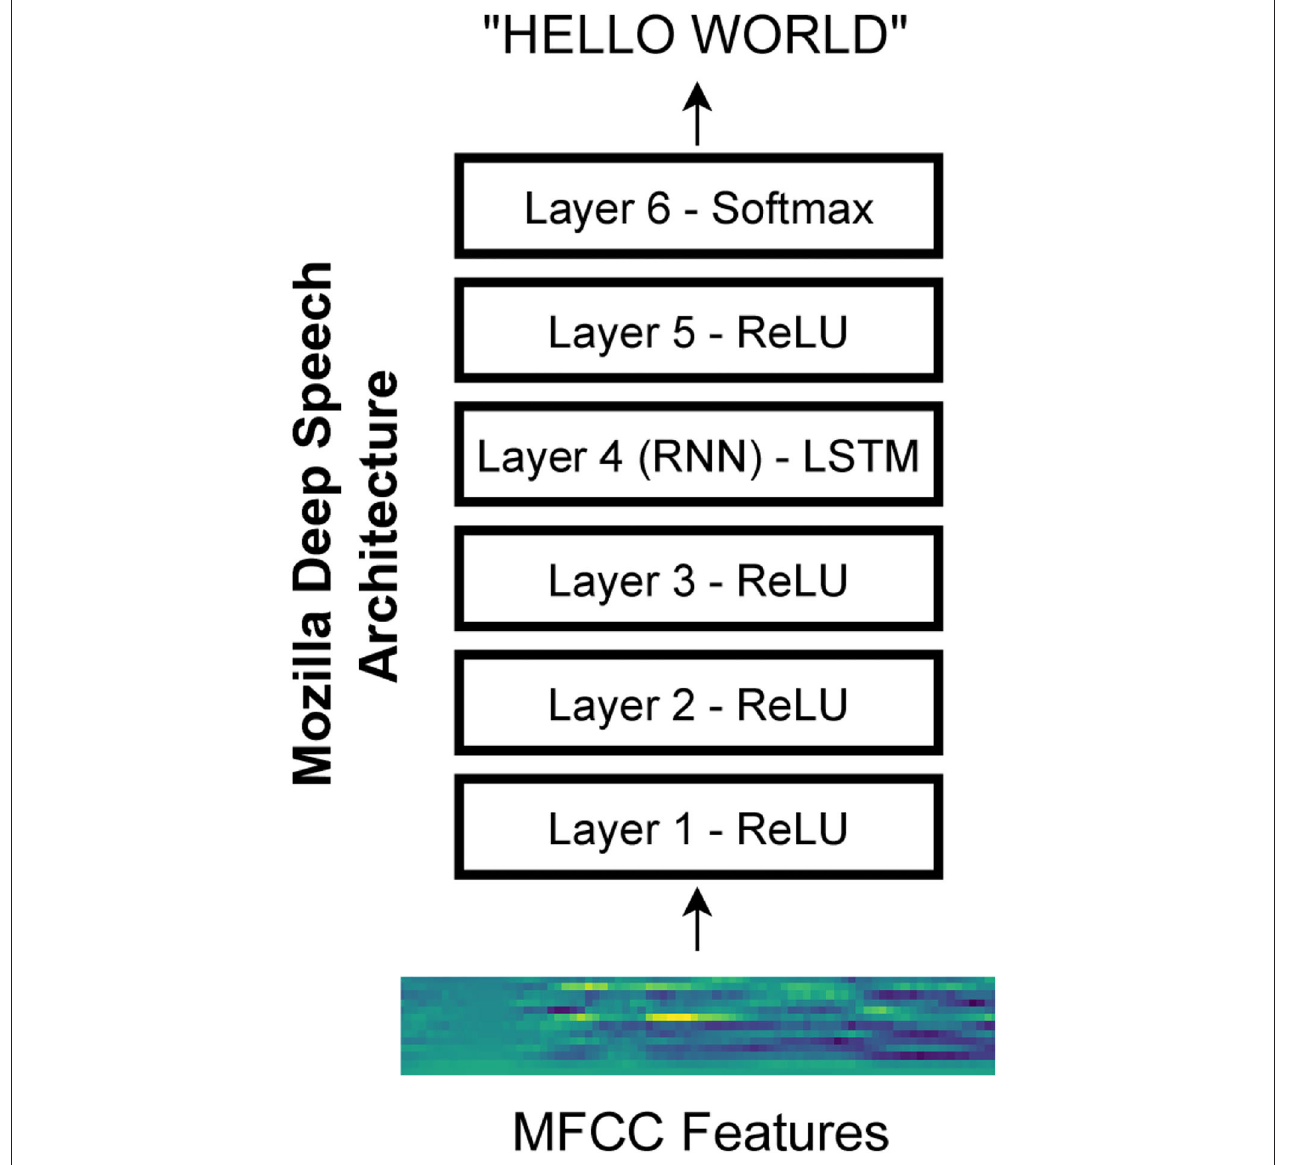
FIGURE 1 | Mozilla deep speech architecture. The recurrent neural network contains five layers of hidden units where the first three layers as well as the fifth layer use a clipped rectified-linear activation function and the fourth layer is a recurrent layer. The last layer uses a softmax function to select the most probable alphabet letter at each timepoint (Hannun et al.,